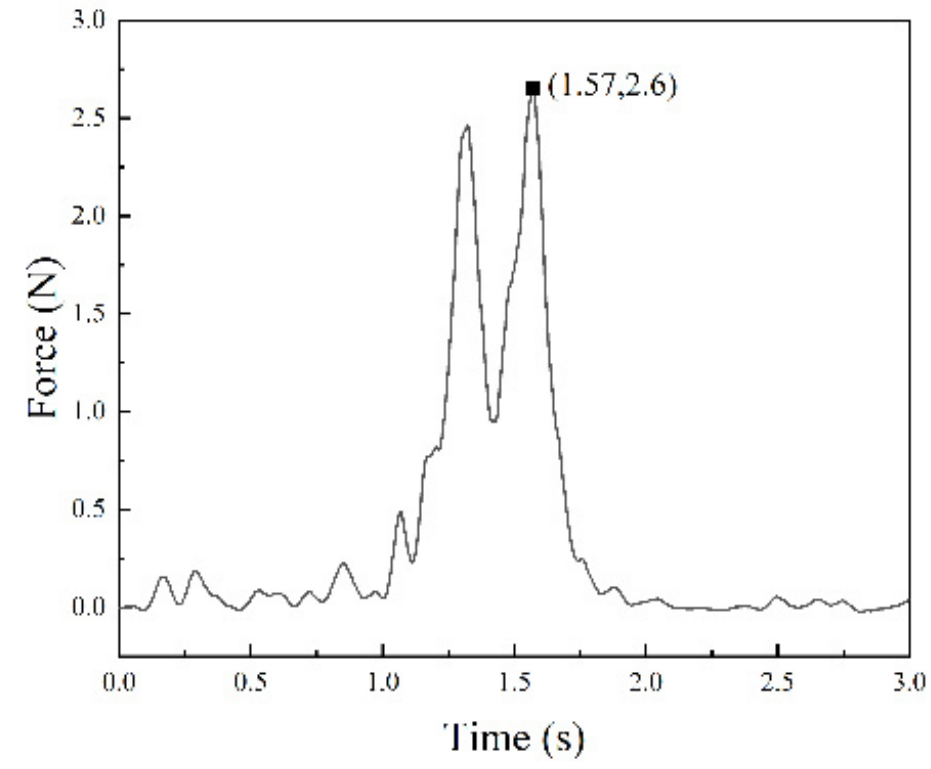
Figure 8. Line segment tension during deployment.